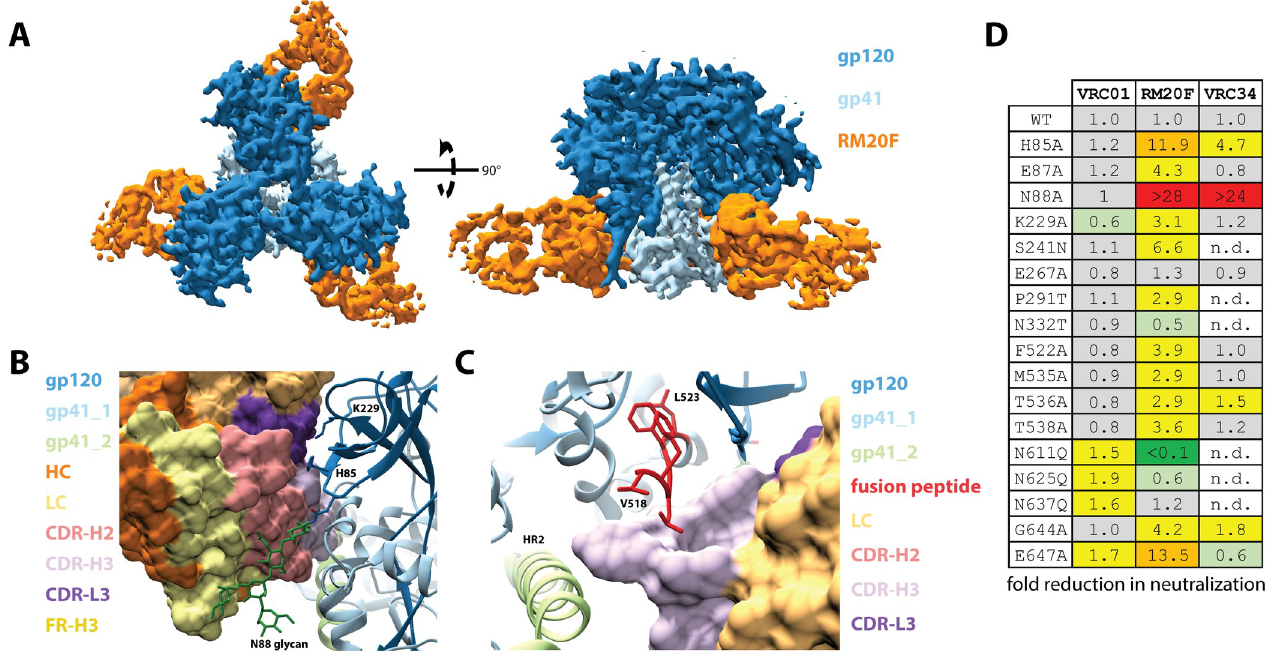
Fig 4. RM20F binds to a quaternary epitope at the gp120/gp41 interface of BG505 SOSIP.v4.1. (A) Segmented 4.3 Å cryoEM reconstruction of RM20F Fab (orange) in complex with BG505 SOSIP (gp120, dark blue; gp41, light blue). (B) and (C) Zoomed-in views of the epitope/paratope interaction between BG505 SOSIP (gp120, dark blue; gp41s, light blue and light green; ribbon diagram) and RM20F Fab (surface representation). (D) Neutralization data for BG505 mutant pseudoviruses against VRC01, RM20F, and VRC34.